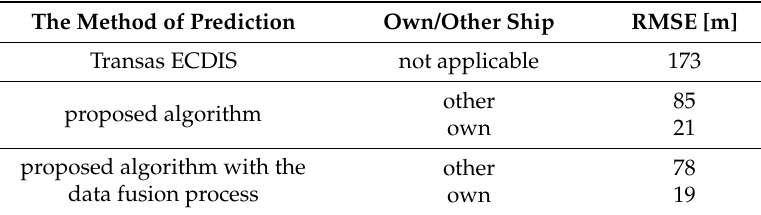
Table 1. The table of root mean square errors of prediction based on the methods